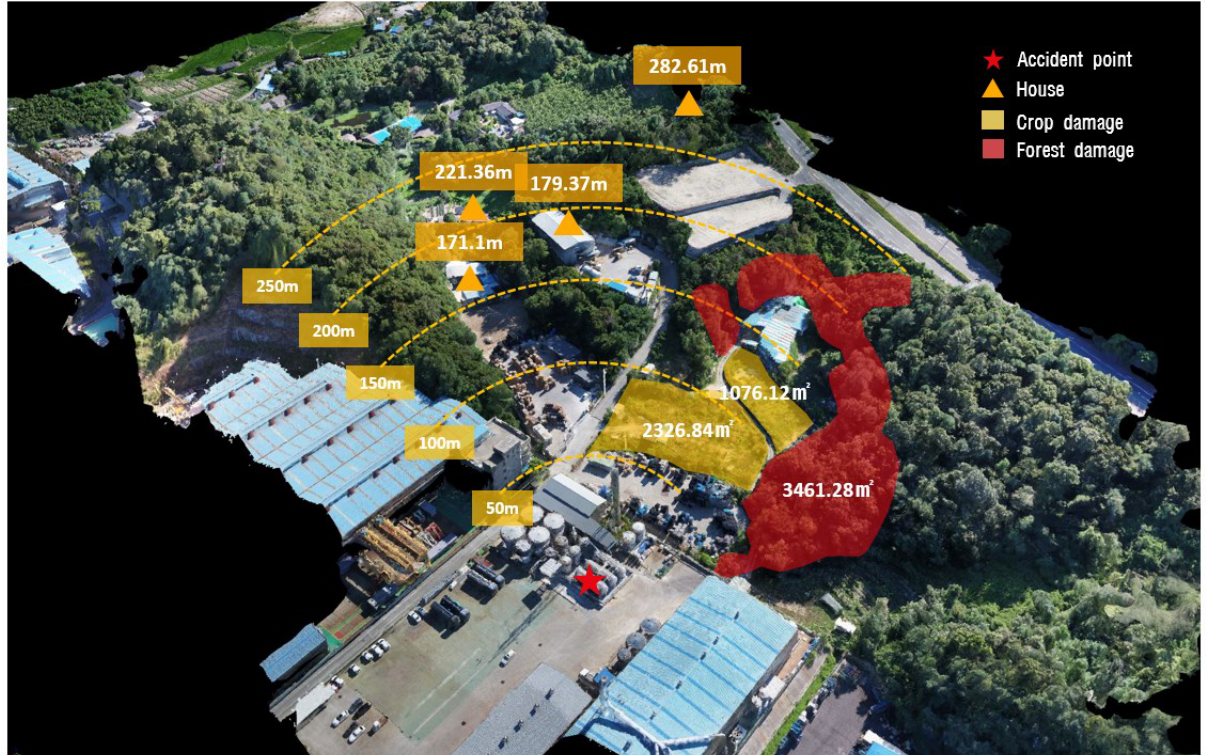
Figure 10 . Residential facility